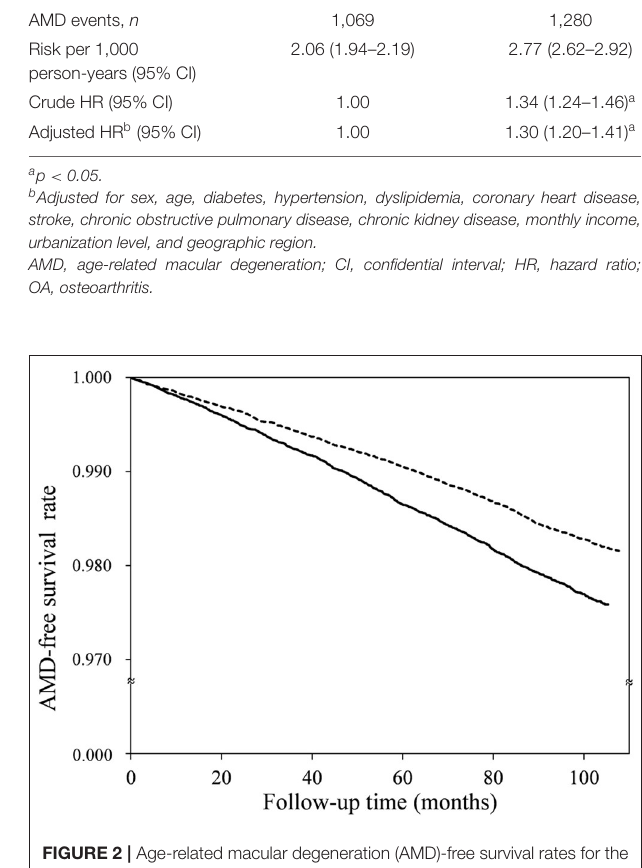
had similar point estimates of adjusted AMD HR (1.28 and 1.31, stratum. The interaction tests showed no significant interaction effect of sex ( p = 0.8617) and no significant interaction effect of age ( p = 0.5068) on the association between OA and